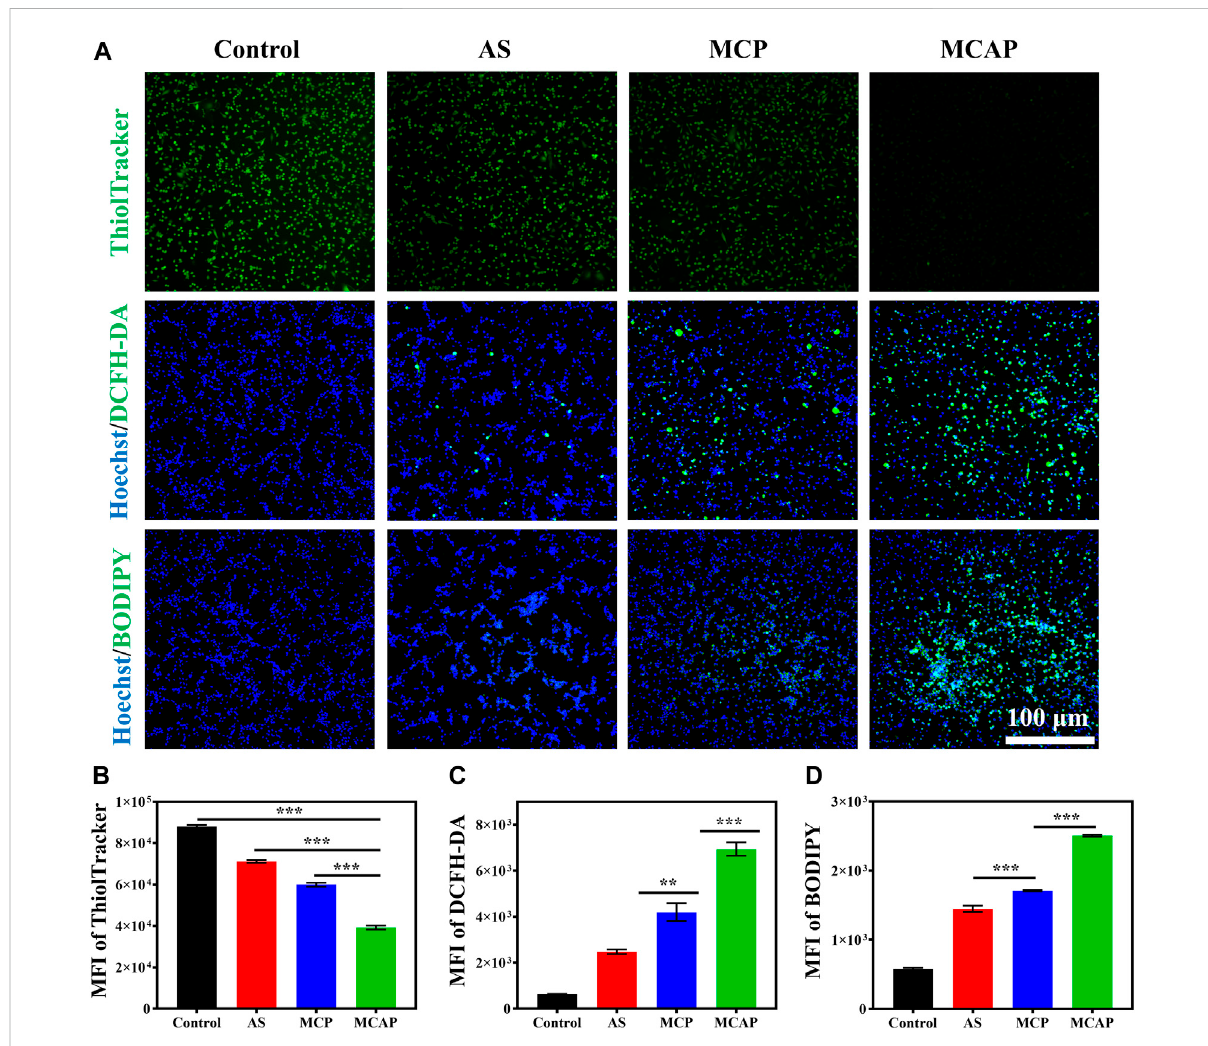
Intracellularoxidativestressampli fi cationofMCAPNPs. (A) FluorescenceimagesofCT26cellstreatedwithvariousagentsandthenstainedwith ThiolTracker ™ Violet (GSH: green color), Hoechst 33342 (nuclei: blue color), DCFH-DA (ROS: green color) and BODIPY (lipid peroxidation: green color). Flow cytometry analysis of CT26 cells treated with various agents then stained with (B) ThiolTracker ™ , (C) DCFH-DA and (D) BODIPY (*** p < 0.001, ** p < 0.01, * p <